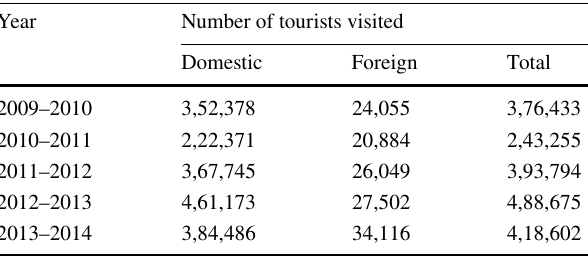
Fig. 1 Trend of population growth and decadal growth Table 2 Tourists inflow in the city during 2009–2014 Source : Tour- ism department, Darjeeling,